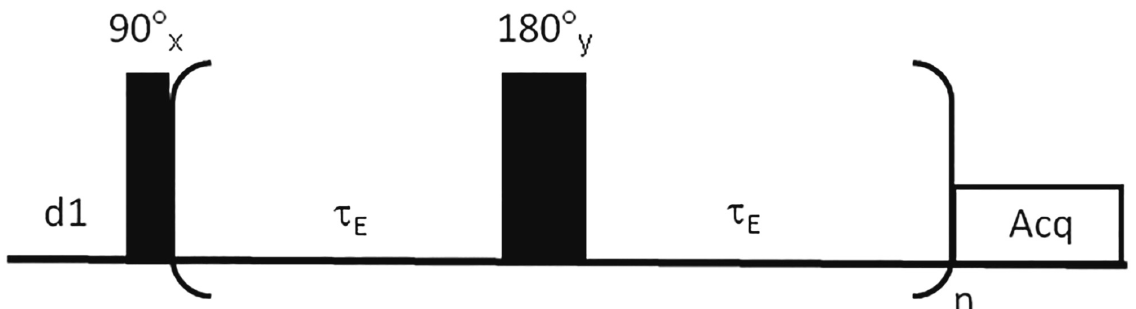
Figure 3. Schematic representation of the Carr–Purcell–Meiboom–Gill (CPMG) pulse sequence (reproduced from [122] with permission). Abbreviations: τ E , echo time interval between the 90 ◦ and adjacent 180 ◦ pulses (the time interval between the 180 ◦ and adjacent 180 ◦ pulses is 2 τ E ); n, number of cycles; Acq, acquisition.